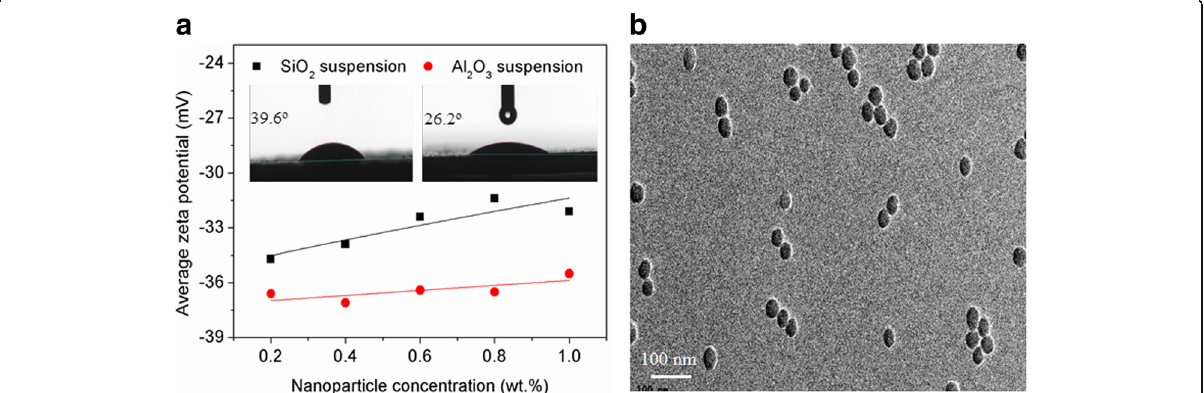
Fig. 1 a Zeta potentials of the aqueous suspensions of Al 2 O 3 and SiO 2 nanoparticles. b Typical TEM image of the aqueous suspension of SiO